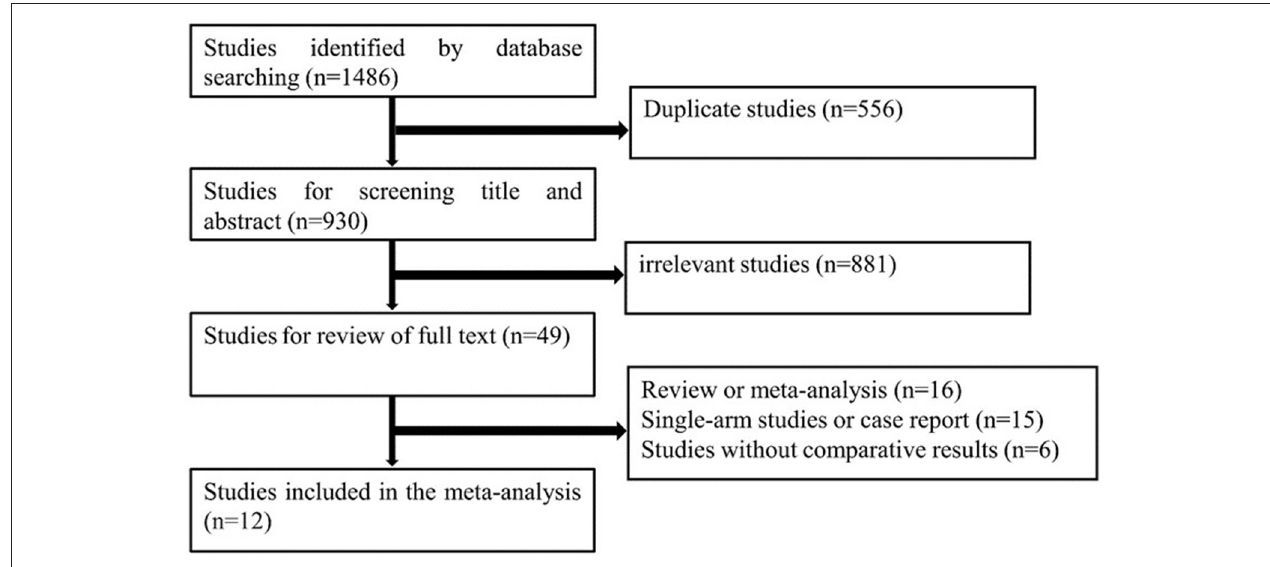
FIGURE 4 | Flow diagram of the selecting